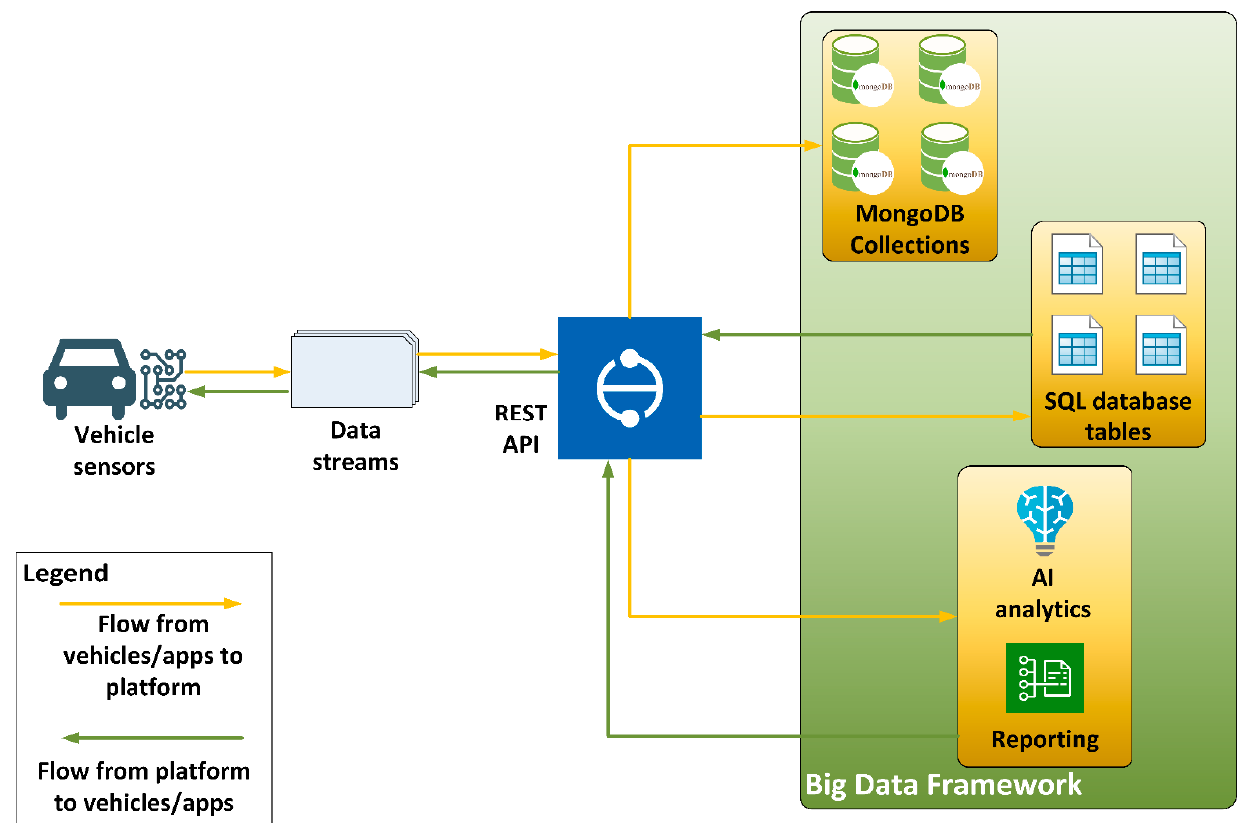
Figure 1. Data flow between vehicles and the hybrid Big Data platform.